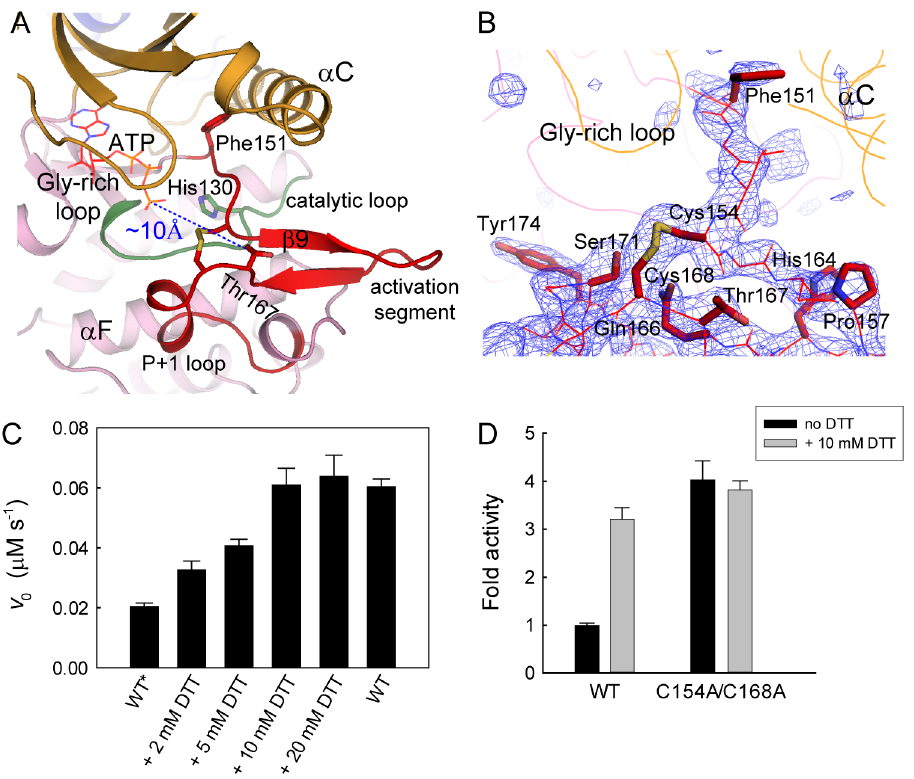
Figure 7. The intramolecular disulfide bond in the activation segment. (A) Ribbon representation of the activation segment of MELK. The molecule is colored as in Figure 2A, except that the catalytic loop is colored green. The intramolecular disulfide bond and certain key residues are highlighted as sticks. The ATP molecule shown as red lines was adapted from PKA (1ATP), and the distance between this potential ATP and Thr167 is indicated by a blue line. (B) The F o - F c omit map (contoured at 3.0 s ) clearly shows electron density for the disulfide bond formed between Cys154 and Cys168. Residues in the activation segment are shown as red lines, and the side chains for Phe151 in the DFG motif, the critical Thr167 and several other residues are highlighted as sticks. (C) Effect of DTT on MELK activity. The wildtype MELK KD-UBA was purified in the absence (WT*) or presence (WT) of 5 mM DTT. The assays were performed in standard kinase assay buffer, in the presence of 1 mM ATP, 10 m M AMARA, 100 nM MELK (WT* or WT) and the indicated concentrations of DTT (mean and s.e.m., n=3). (D) The activity of the cysteine mutant is DTT independent.